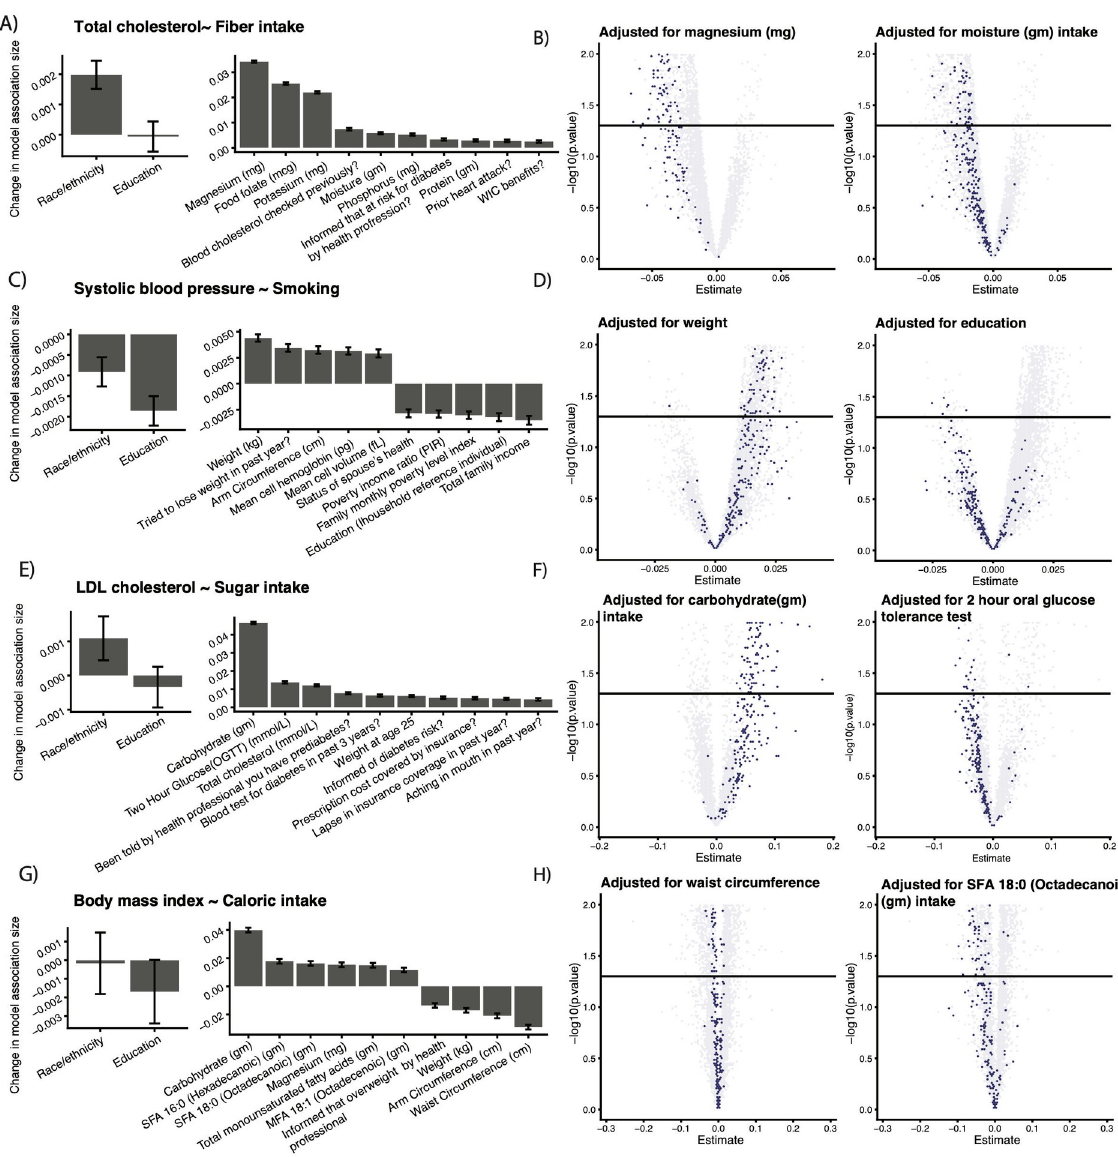
Fig 4. Examples of adjusters that appear to drive VoE for highly confounded associations. Rows: associations with particularly high JEs for each dependent variable. Left column: established variables known to confound cardiovascular risk factors. Middle column: top 10 adjusters (not found in the left most column) whose presence is correlated to changes in the associations reported on the rows. Right columns: vibration plots from Fig 3 (rescaled on the axes) colored by if the adjuster in the plot title was present in models represented by a given point. The solid line is nominal ( p < 0.05) significance. Data underlying these plots are available at https://figshare.com/account/ home#/projects/120969 and S2 Table. JE, Janus effect; LDL, low-density lipoprotein; MFA, Monounsaturated Fatty Acids; OGTT, oral glucose tolerance test; PIR, poverty income ratio; SFA, Saturated Fatty Acids; VoE, vibration of effects; WIC, Women, Infants, Children.